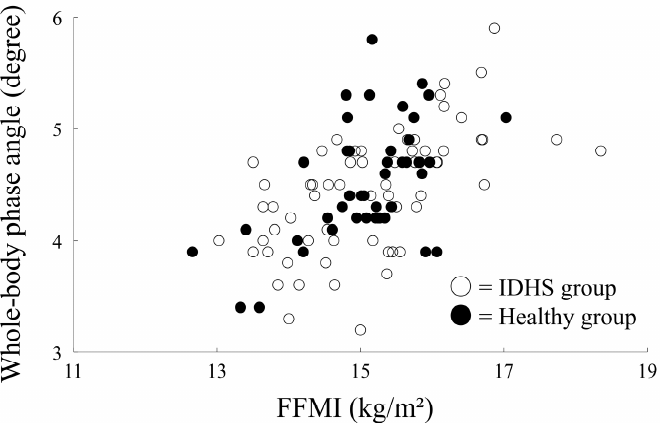
Figure 2. Correlation between FFMI and phase angle in both groups. From the relationship of body composition data in the statistical correlation analy- sis, McGS was revealed to be significantly correlated with the whole-body phase angle ( r = − 0.31, p = 0.043) (Table 3, Figure 4A) and lower extremity phase angle ( r = − 0.39, p = 0.009) (Table 3, Figure 4B). There was no significant correlation detected between McGS and the other variables. As a result of post hoc power analysis (two tales, effect size ρ = 0.39, type I error probability = 0.05, sample size = 43), the power was 77% (i.e., type II error probability = 0.23), and sufficient detection power was obtained for the correlation between McGS and lower extremity phase angle in the IDHS